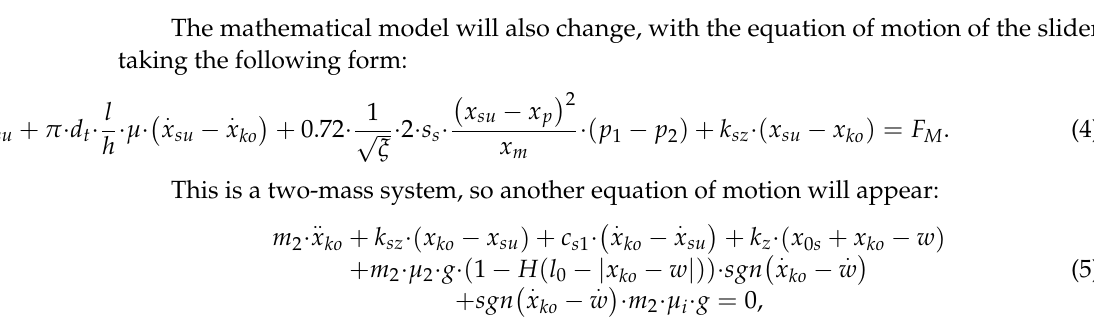
Figure 9. The supporting graphs of research: ( a ) the “black box” method in valve vibration; ( b ) ratio of simulator table acceleration a 2 to directional control valve body acceleration a 0 as a function of frequency.